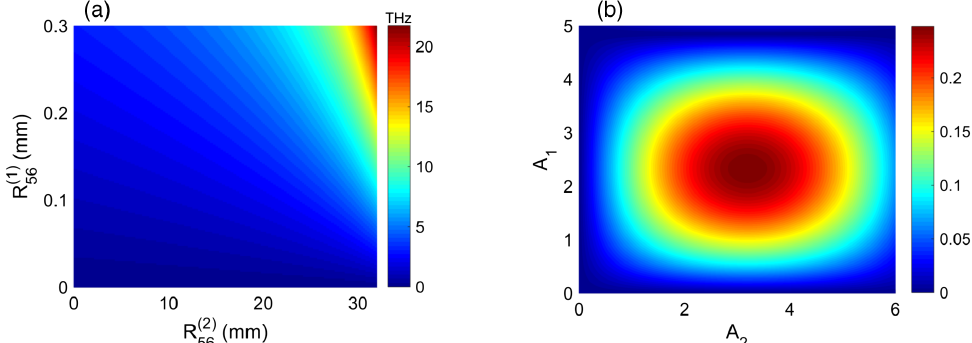
FIG. 2. (a) Central frequency of the density modulated electron beam VS dispersion strengths R 56 ; (b) Bunching factor VS laser modulation amplitudes A .